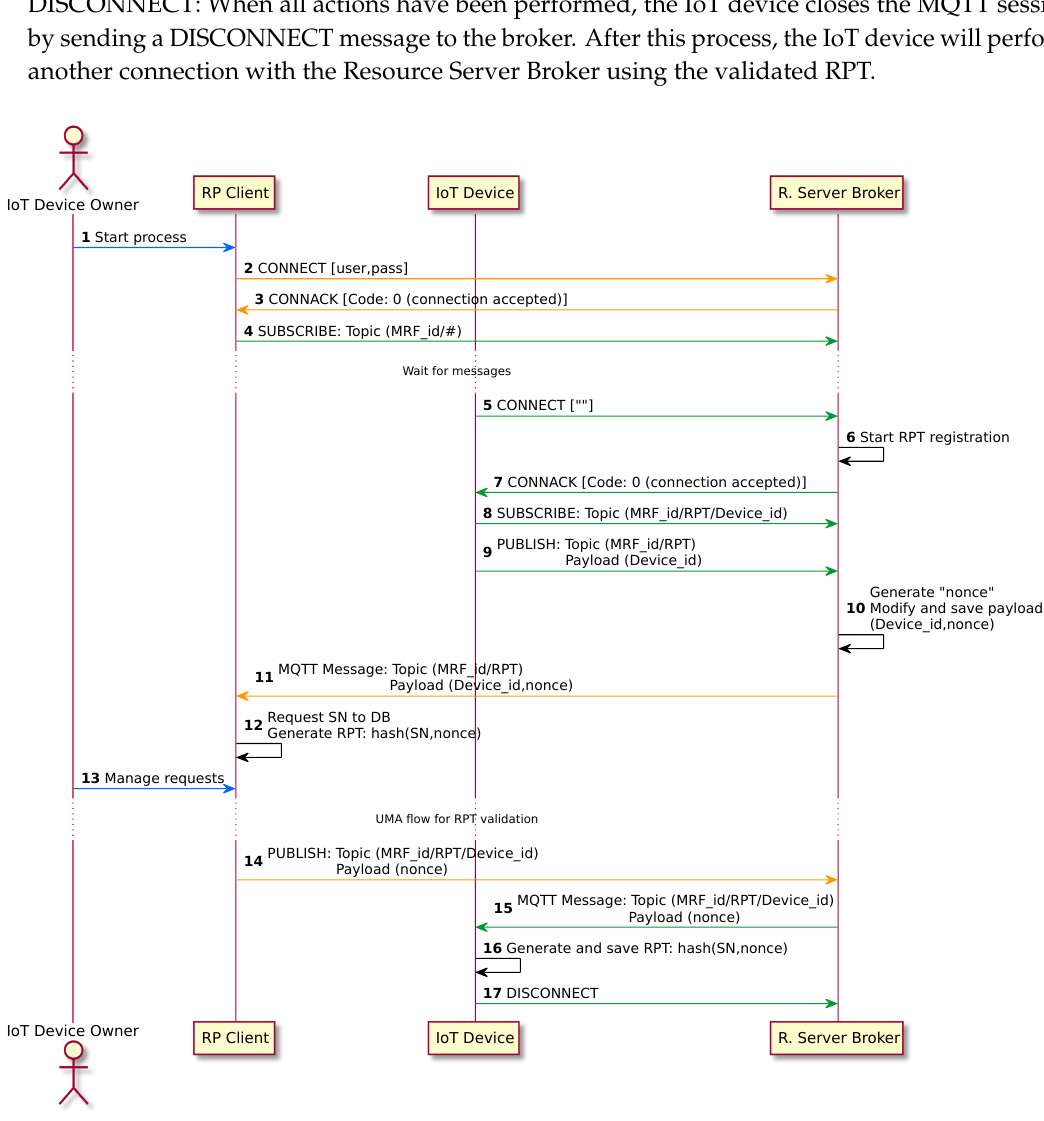
Figure 5. SequencediagramforRequestingPartyToken(RPT)validation. DB:Database; MRF:Manufacturer; SN: serial